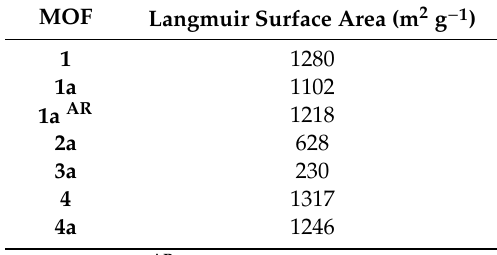
Table 2. Langmuir surface areas of prepared UiO66 -based MOFs.